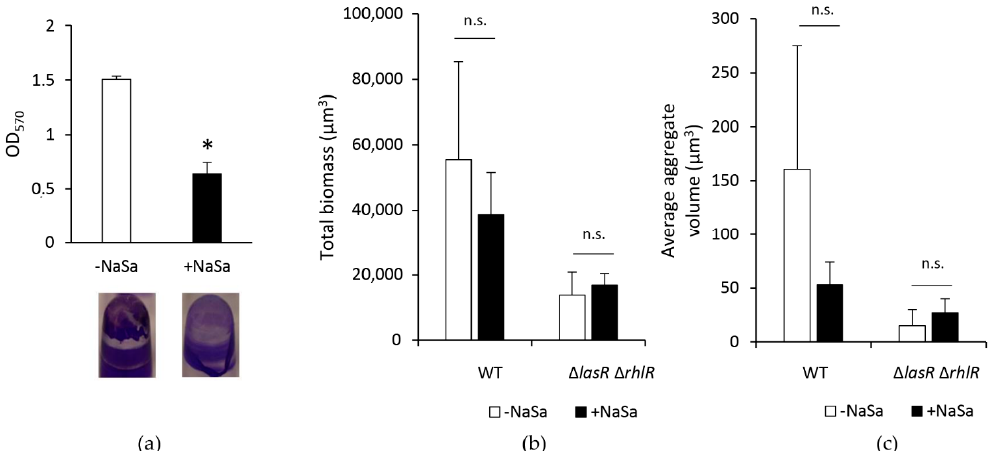
Figure 3. Inhibitory effect of 10 mM sodium salicylate (NaSa) on P. aeruginosa biofilm formation on ( a ) polystyrene pegs and ( b , c ) collagen-coated glass. ( a ) NaSa reduced biofilm biomass formed on polystyrene pegs by PAO1 wt grown in the presence or absence of 10 mM NaSa for 48 h using the Calgary biofilm device, as measured by mean OD of crystal violet. ( b ) Total biofilm biomass formed by PAO1 wt-GFP and PAO1 ∆ lasR ∆ rhlR -GFP and ( c ) average aggregate size was not affected by NaSa. Mean ± SD, n = 3. * p < 0.05 using Student´s two-sided t-test compared to the control (0 mM NaSa). n.s. is